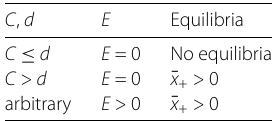
Table 4 Existence of equilibria for a > 0, f = 0